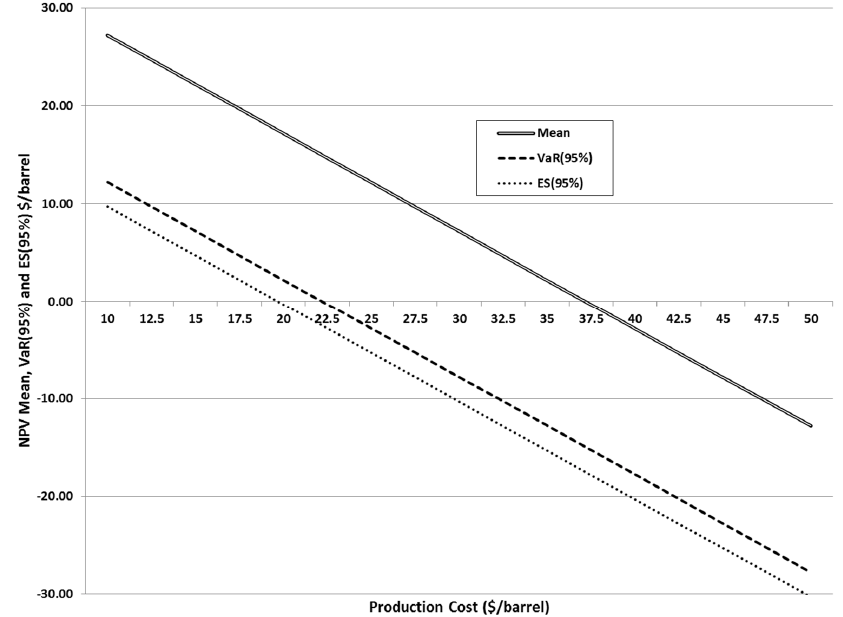
Figure 7. Unit net present value ( NPV ) (average), value at risk (VaR), and expected shortfall (ES) as a function of unit production costs.